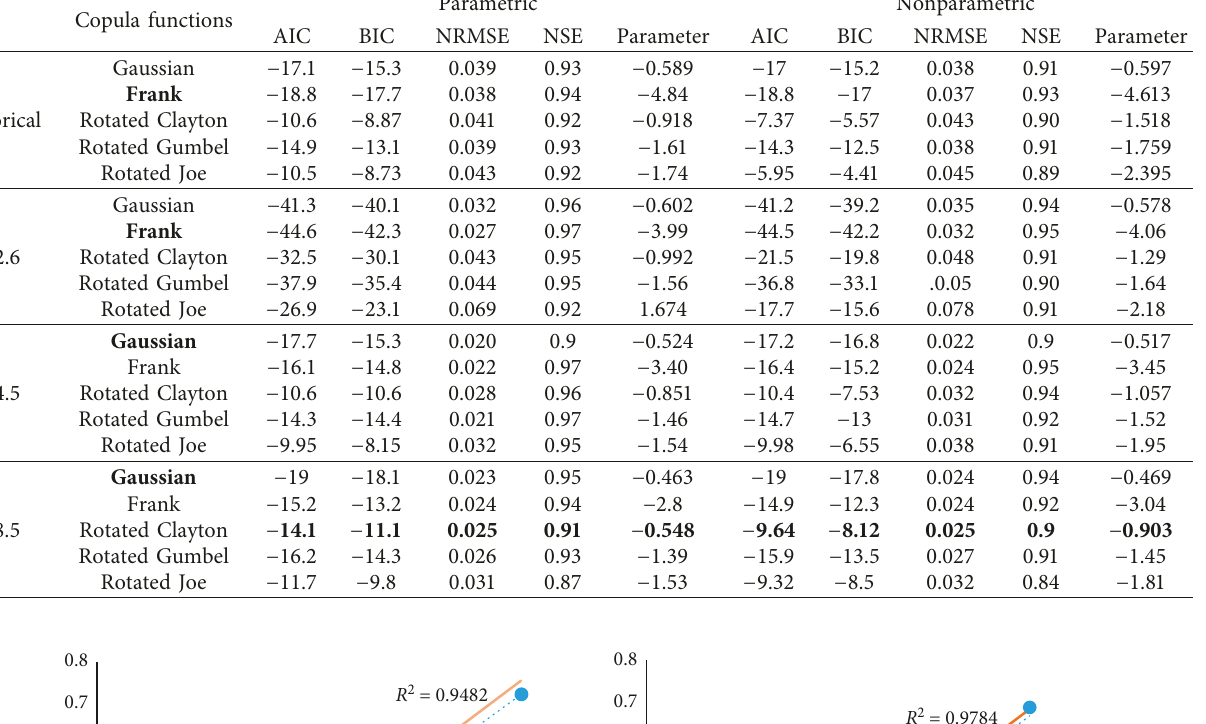
Table 9: Selection criteria of the best fit of copula functions for historical and future periods.